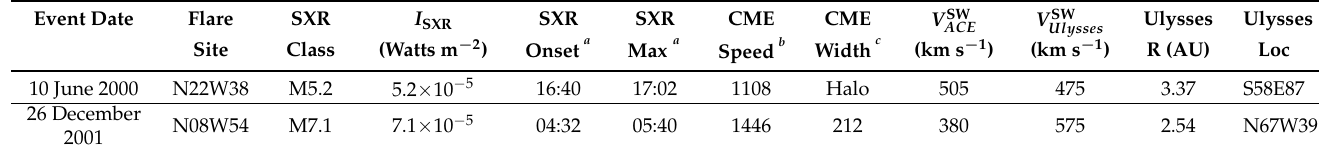
Table 1. Observational parameters and their solar origin for the SEP